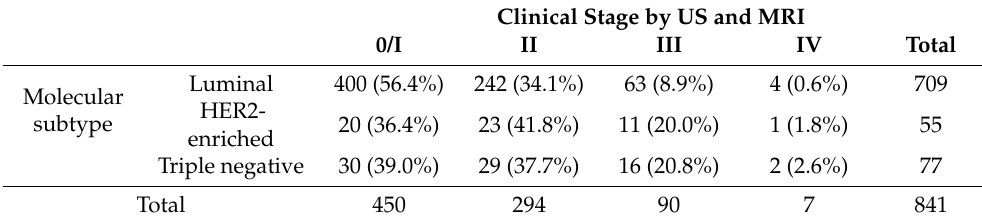
Table 3. Distribution of clinical stage according to molecular subtype ( n = 841).